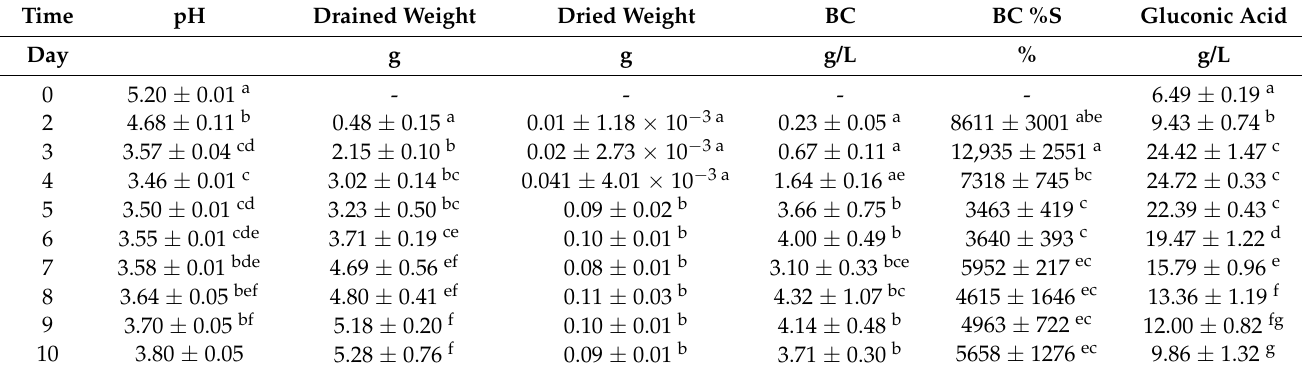
Figure 2. Cellobiose, gluconic acid, glucose and 5-(hydroxymethyl)-2-furaldehyde (HMF) concentration (g/L; mg/L) of the control culture medium during the incubation time. Values are shown as means and standards deviation. Table 1. Parameters analyzed at each incubation time in bagasse–potato culture medium: pH, bacterial cellulose (BC) drained weight (g), BC dried weight (g), BC concentration (g/L), BC swelling capacity (%S) and gluconic acid concentration (g/L).